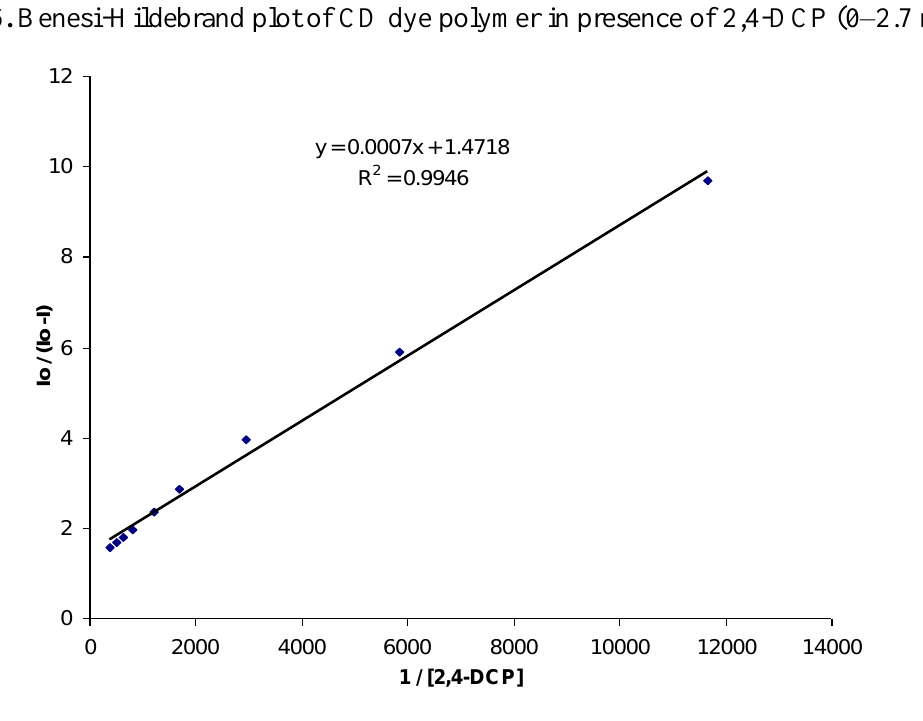
Figure 6. Benesi-Hildebrand plot of CD dye polymer in presence of 2,4-DCP (0–2.7 mM).